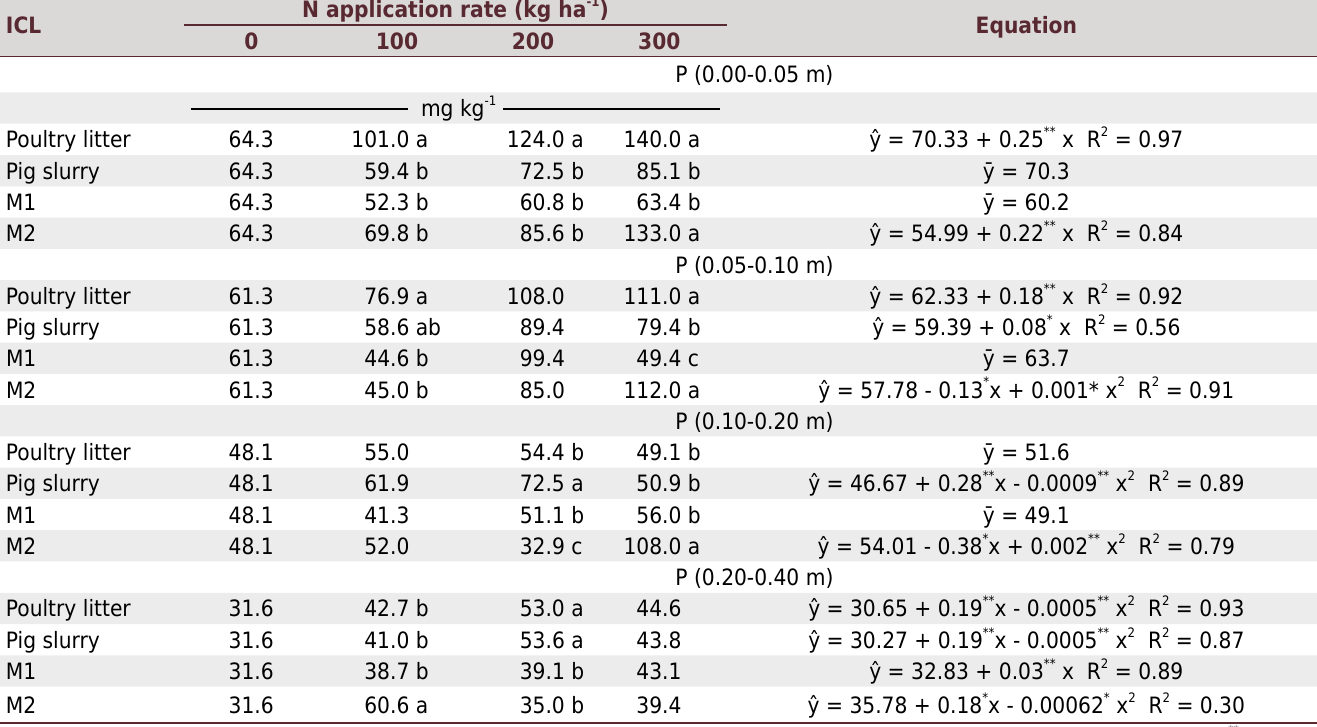
Table 5. Phosphorus content in soil according to organic and mineral fertilizer application in integrated crop-livestock systems in 2013 N application rate (kg ha -1 ICL